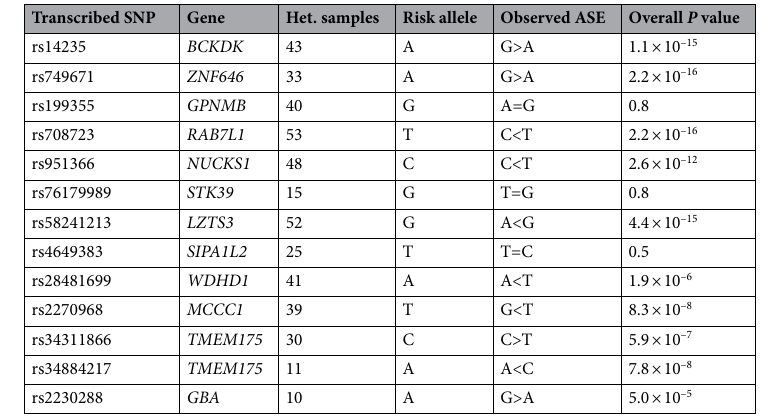
Table 2. Allelic expression results for 12 Parkinson’s disease genome-wide associated genes in human brain samples. The overall P value was calculated using a non-parametric Mann–Whitney U test comparing the allelic expression of all genomic DNA samples with all cDNA samples. SNP single nucleotide polymorphism, Het heterozygous, ASE allele-specific